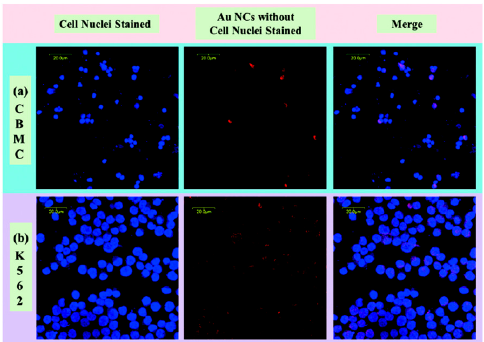
Figure 9. Confocal microscopic Images of ( a ) CBMC; normal cells; ( b ) K562; cancer cells, after incubation with Au NCs in a medium containing fetal calf serum (FCS) for 24 h. The nuclei of cells were tainted with Hochest-33258 to yield blue fluorescence and the red fluorescence is due to the presence of Au NCs [94]. The scale bar is 20 µm.